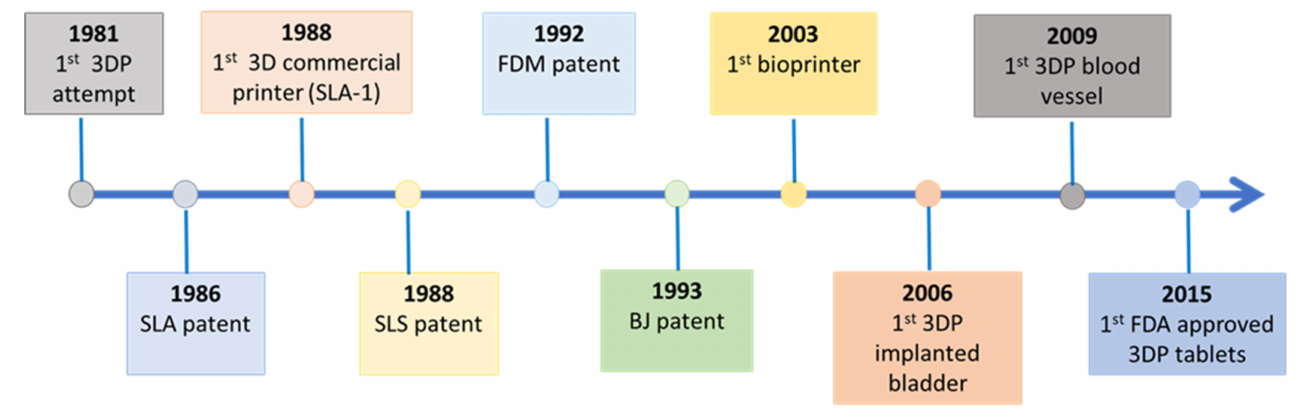
Figure 1. Invention and development of different 3DP techniques and